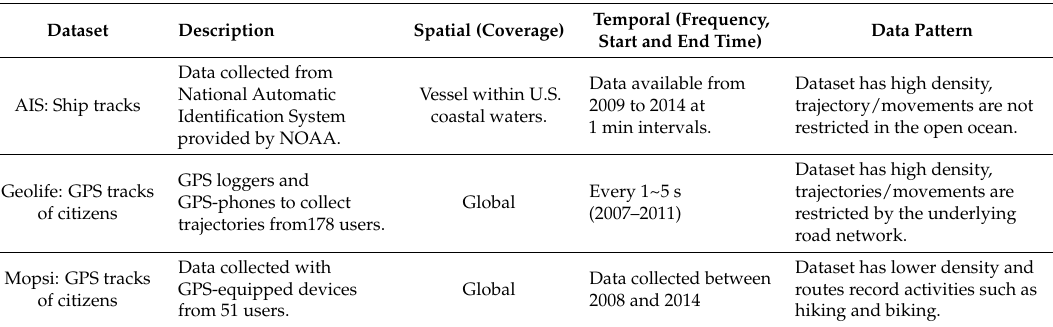
Table 3. Description of AIS [30], GeoLife [9] and Mopsi [14]